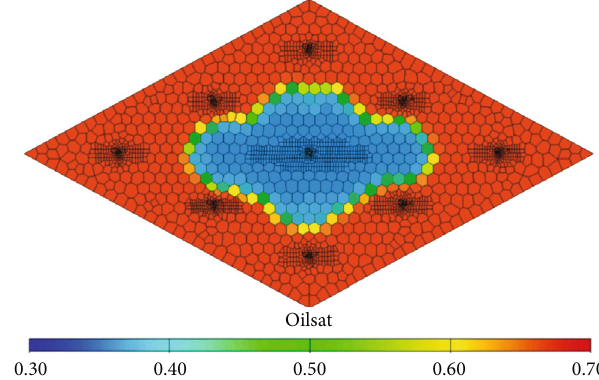
Figure 5: Distribution characteristics of seepage fi eld in the 10-year period of the original development mode.